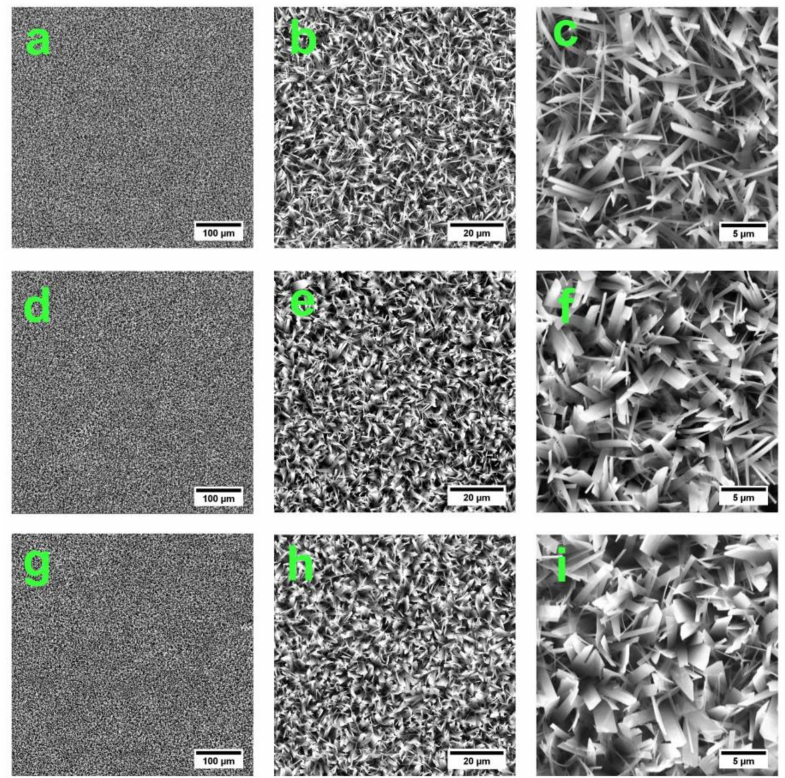
Figure 2. Scanning electron microscopy (SEM) images at di ff erent magnifications evidencing the morphology of the H ( a – c ), H-Mg1 ( d – f ), and H-Mg1.5 ( g – i ) based